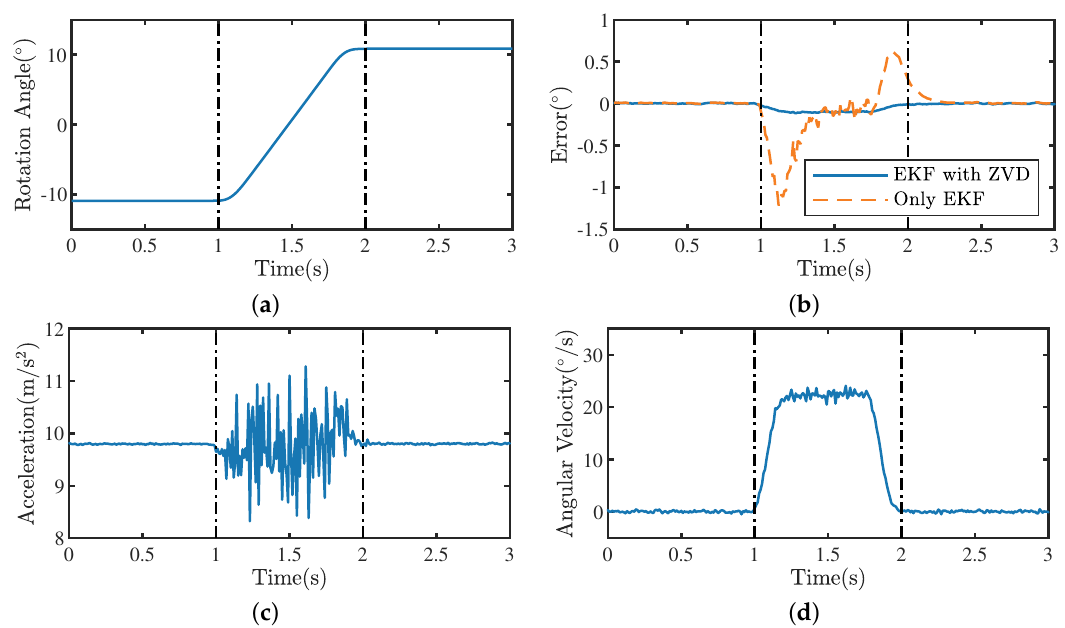
Figure 9. An example of the EKF with ZVD and the EKF applied to the data recorded by the RAMS. ( a ) Reference rotation angles obtained by a precision turntable. ( b ) Angle estimation errors of the EKF with ZVD (solid lines) and the EKF (dashed lines) with respect to the reference angles. ( c ) Magnitudes of the acceleration. ( d ) Magnitudes of the angular velocity.